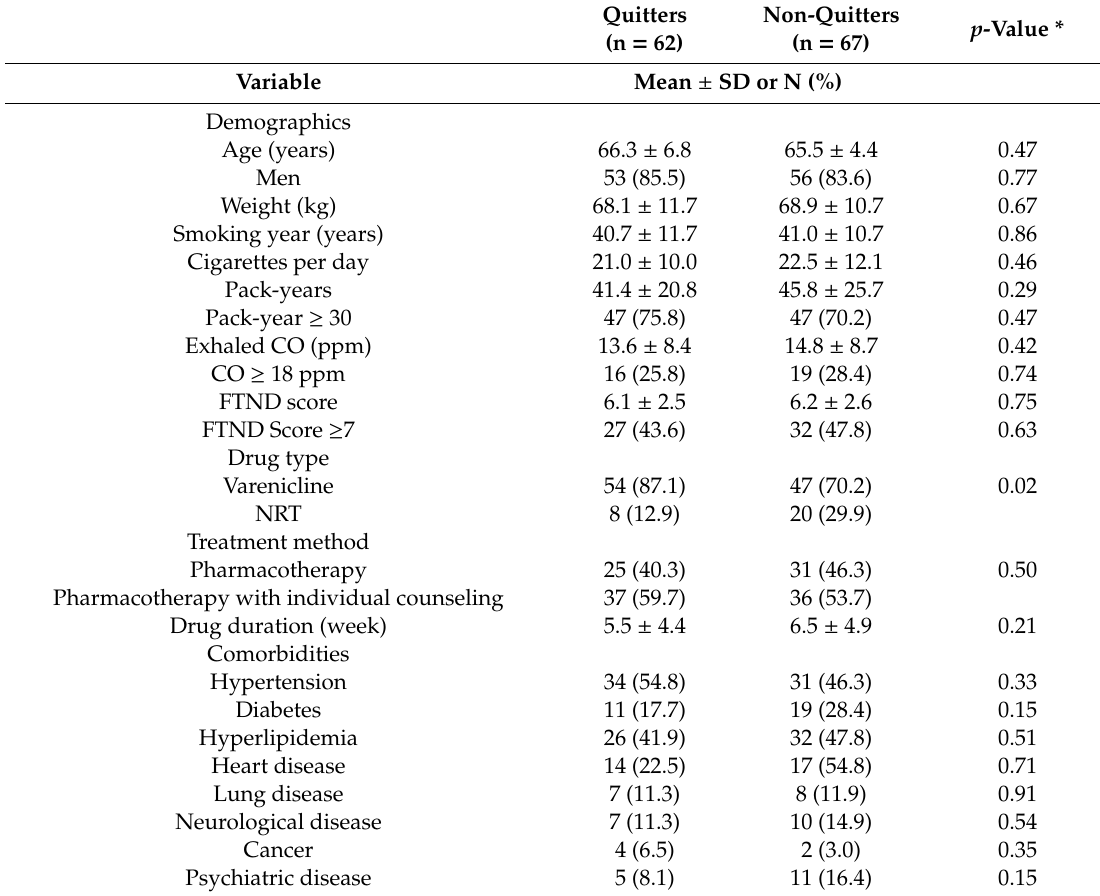
Table 2. Comparison of baseline characteristics related to smoking cessation among quitters and non-quitters.